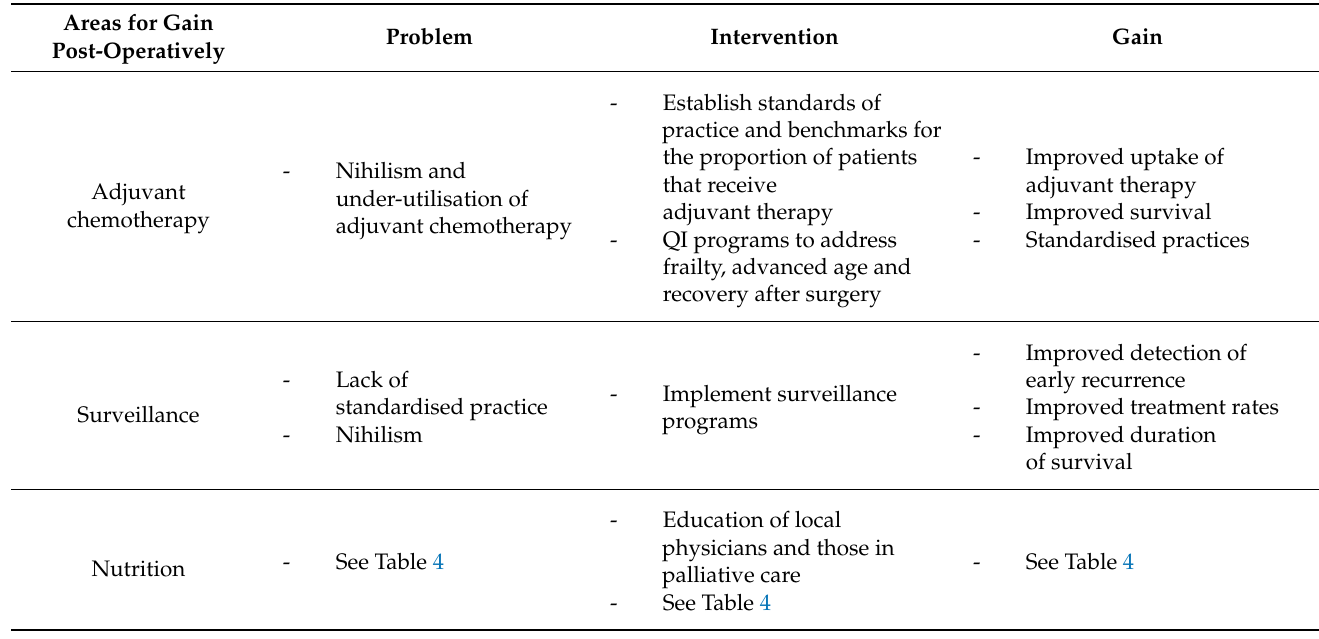
Table 6. Areas for Post-operative